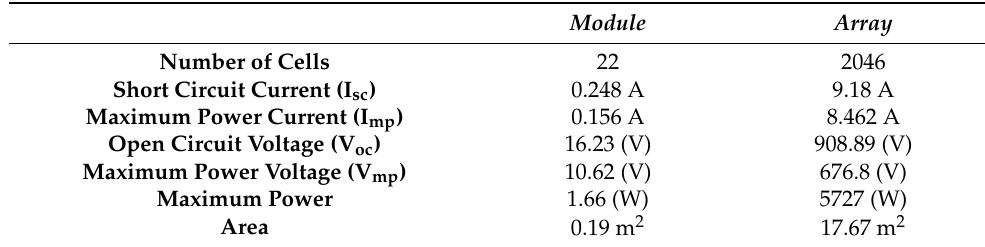
Table 1. The dye-sensitized solar module and array